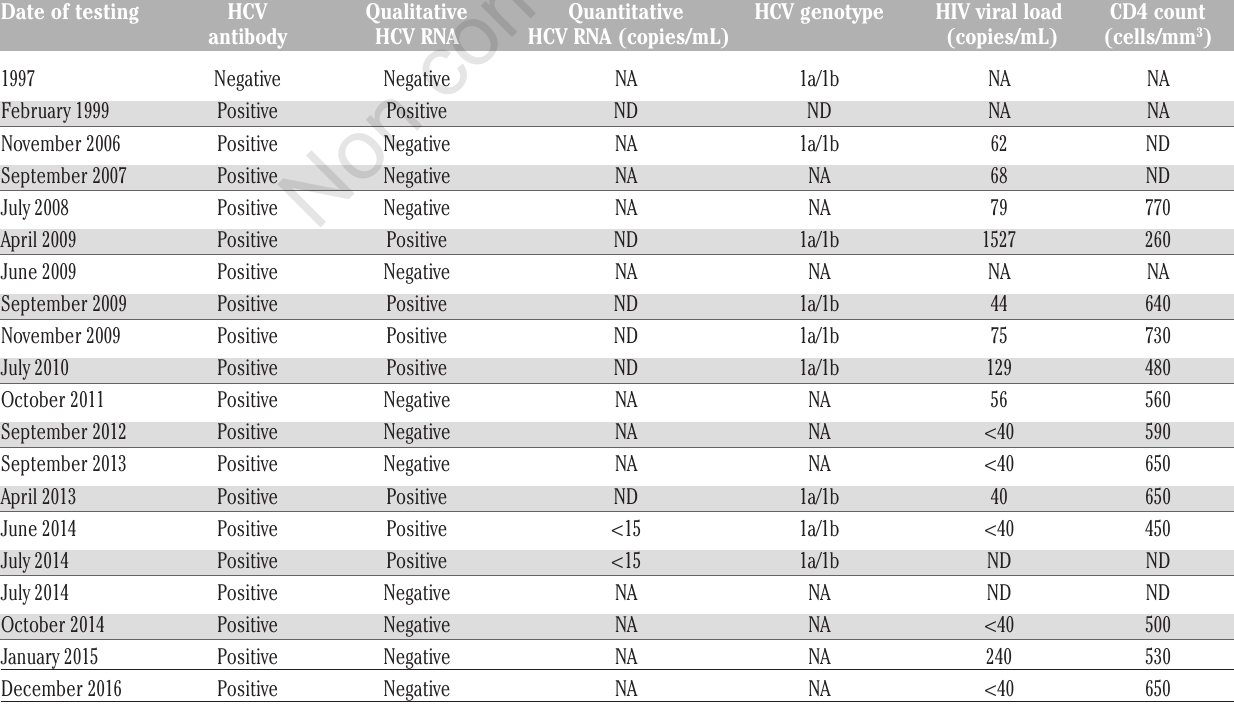
Table 1. Hepatitis C virus and HIV-related laboratory data